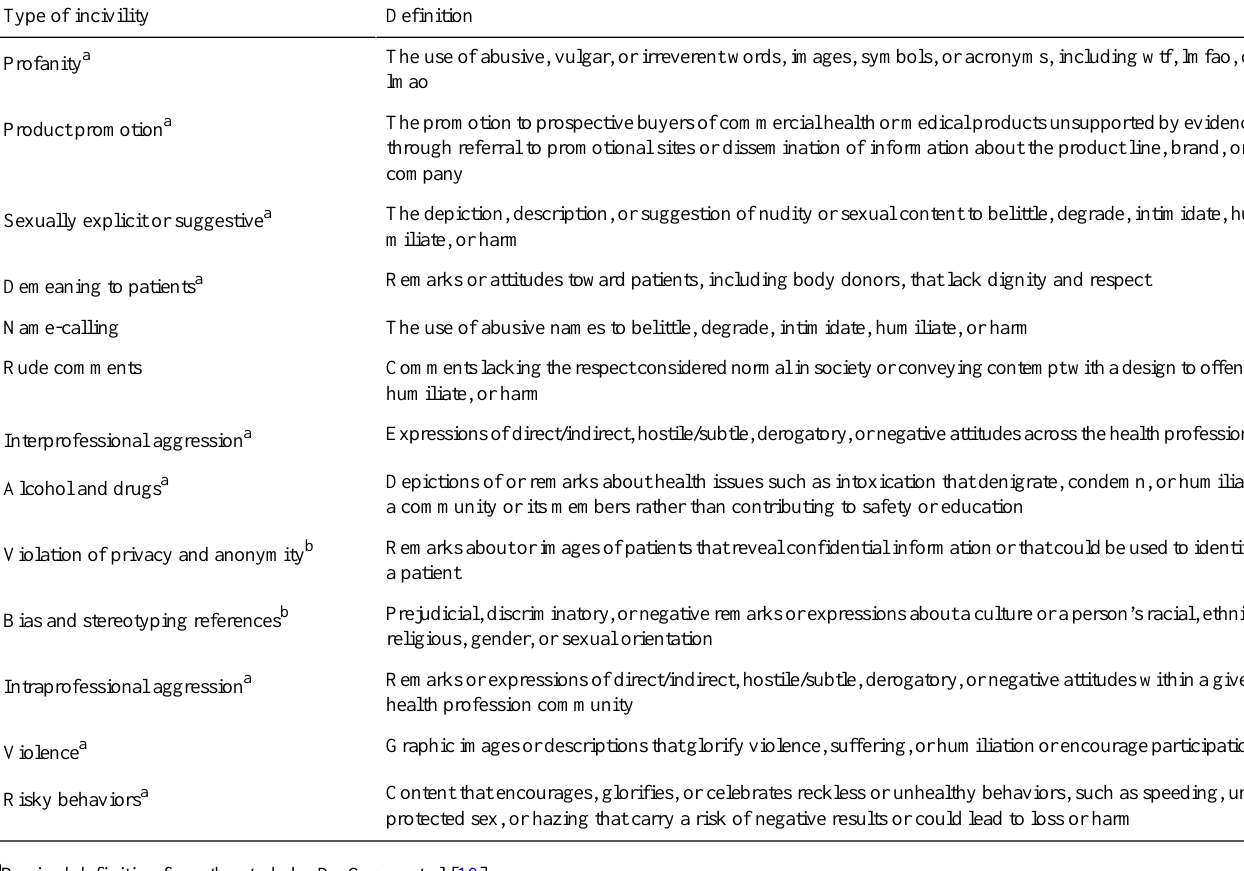
Table 1. Codebook used in the study. DefinitionType of